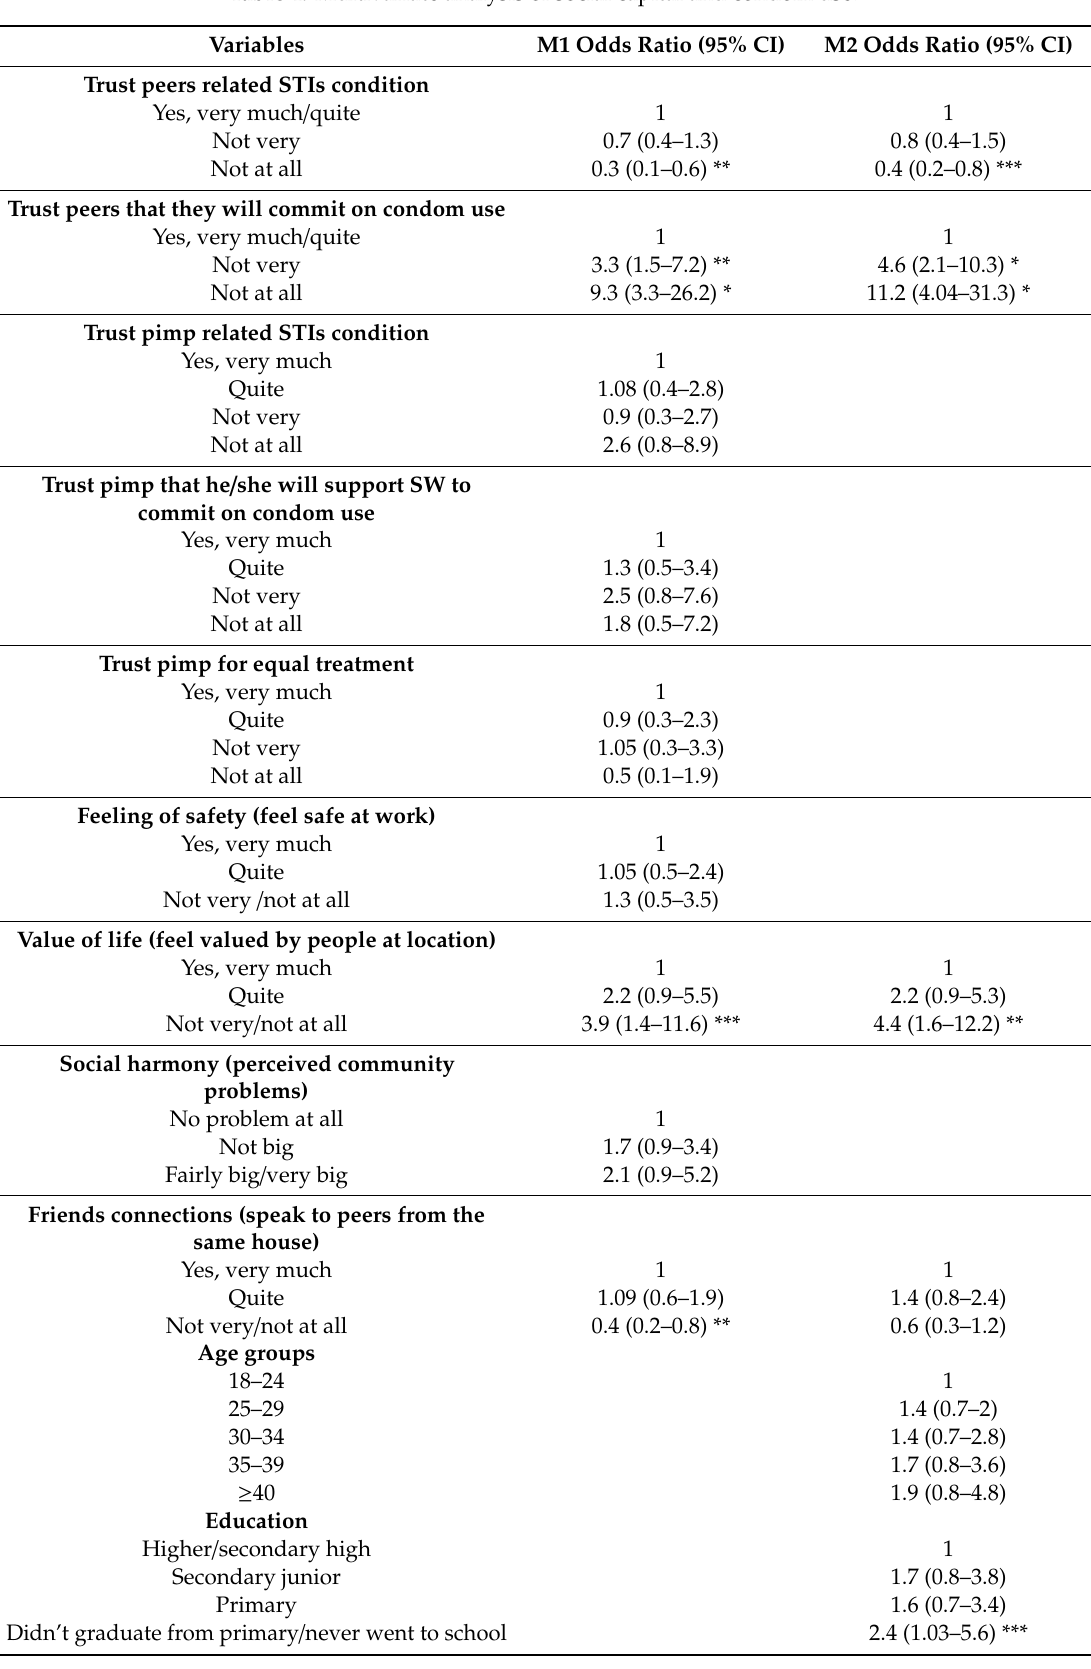
Table 4. Multivariate analysis of social capital and condom